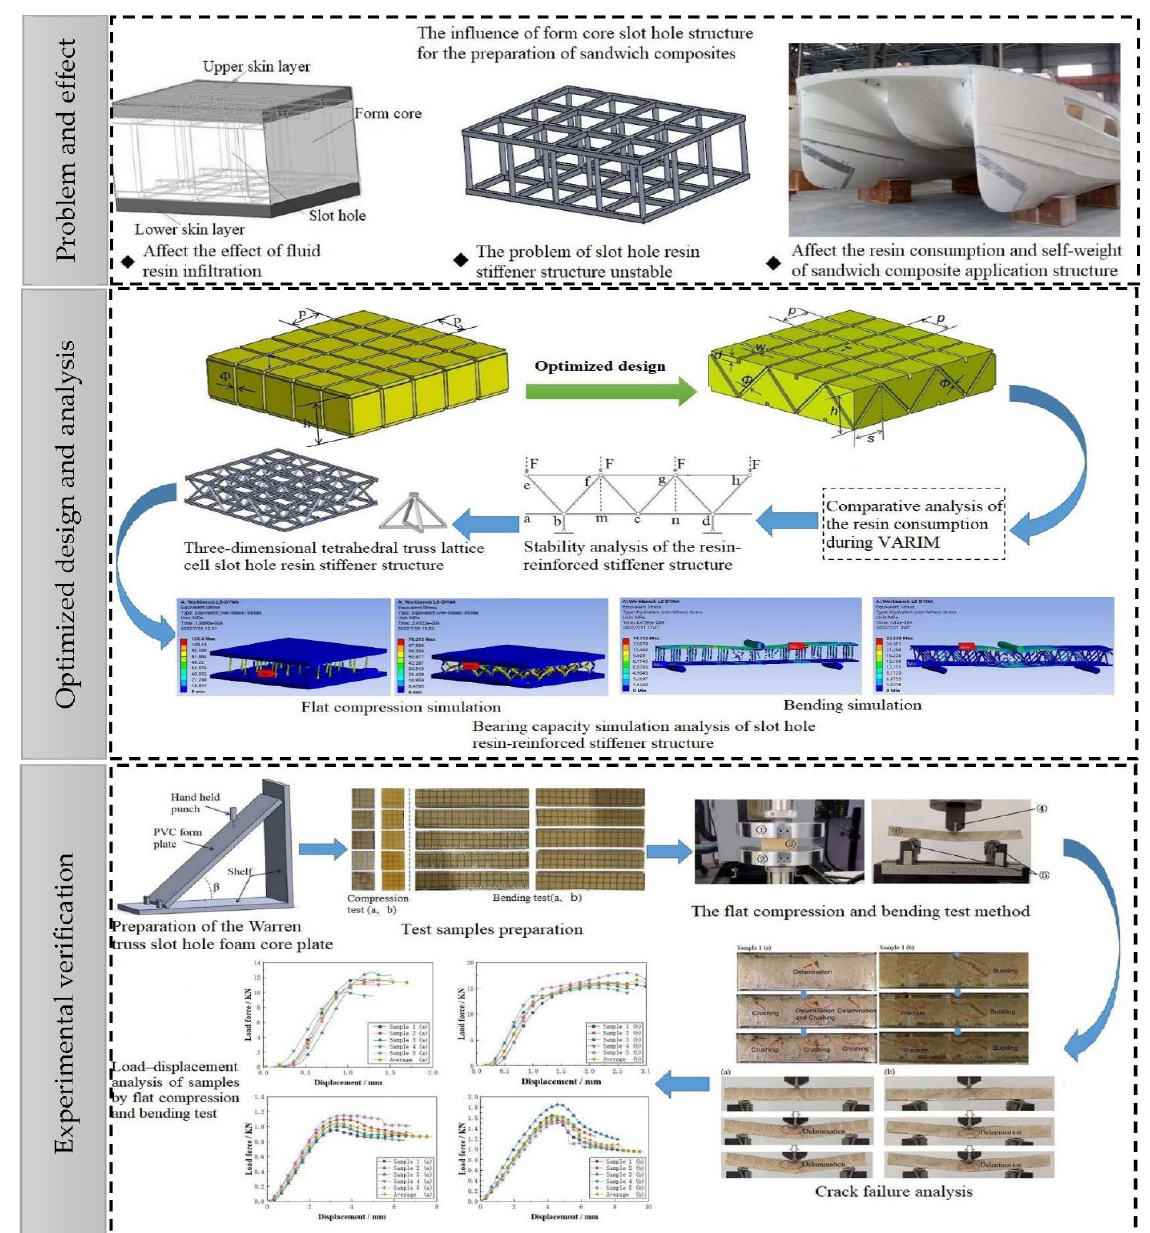
Figure 1. Technical flowchart for the comprehensive characterization of the improvement of the foam- core sandwich composite’s capacity and strengths from the problem analysis of the slot-hole structure, which is optimized to a Warren truss slot-hole structure, and the advantages of the optimized slotted resin-stiffener-reinforced sandwich composites are verified by